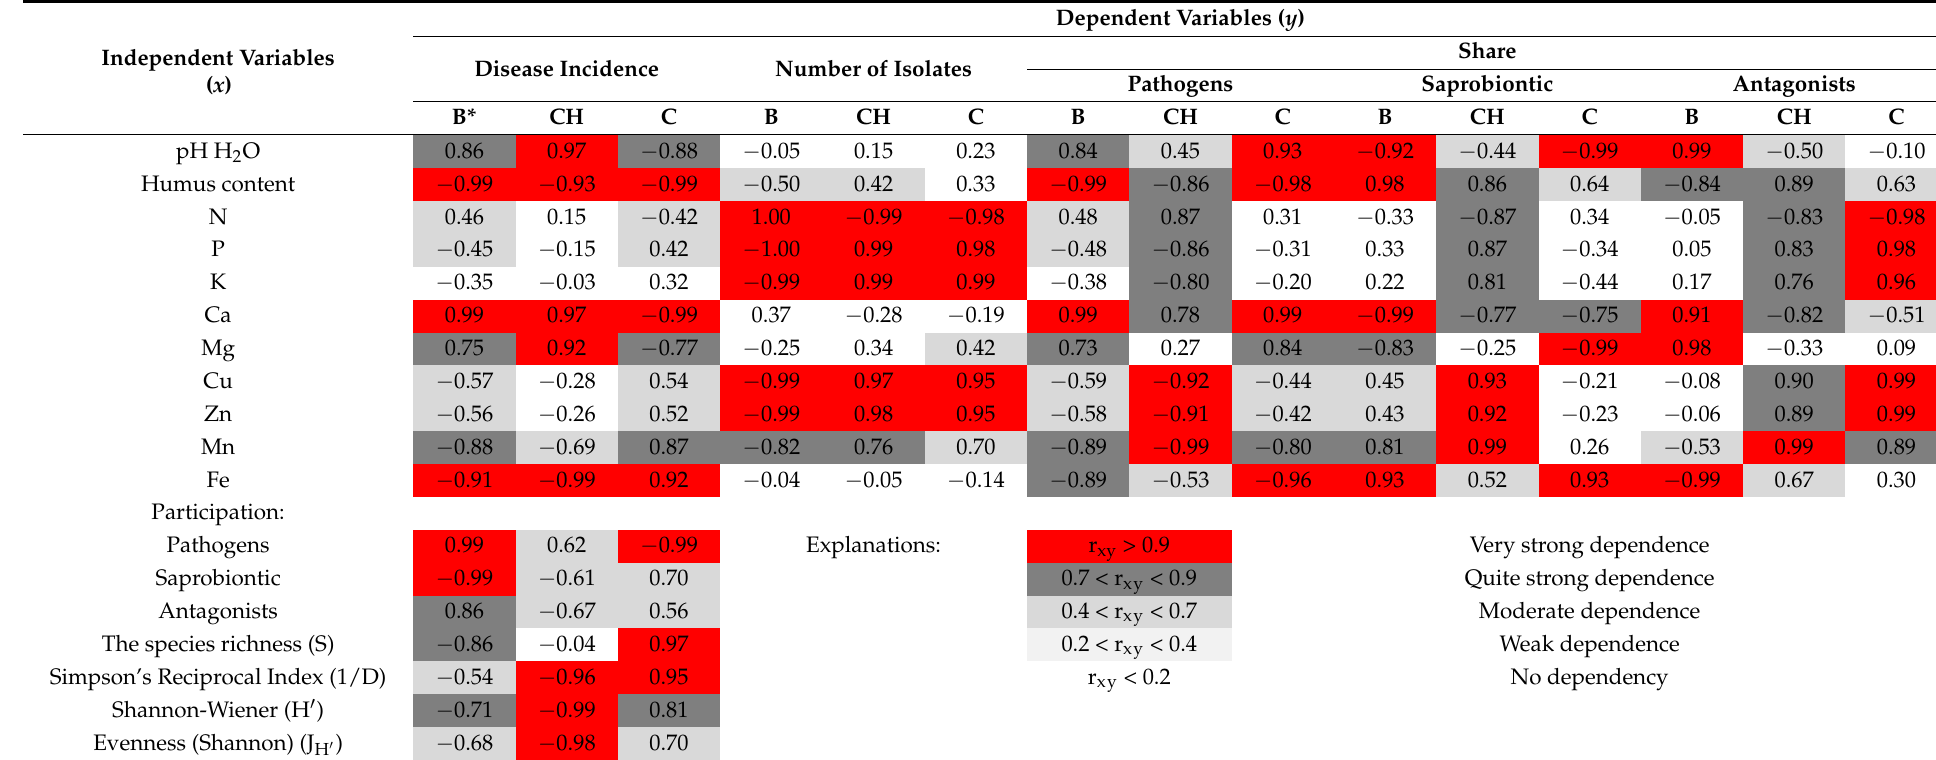
Table 4. Relationship between the structure of a microorganism community colonizing infected seedlings, biodiversity indices, assimilable macro- and micronutrient forms, and the incidence of pre-emergence damping-off and its associated microorganisms (correlation